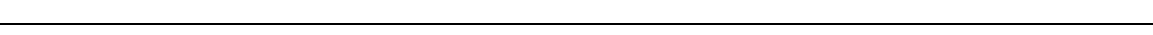
TSA. Protein level of SRSF5 was measured by immunoblotting and MG132 treatment was used as a positive control. b Endogenous SRSF5 is acetylated. Endogenous SRSF5 protein was puri fi ed from HEK293T cells after NAM and TSA treatment as indicated. Acetylation levels were analyzed by immunoblotting. c In vivo competition between ubiquitylation and acetylation of SRSF5 were revealed by Ni 2 + pull-down assay. d Overexpression of Tip60, but not other typical members of acetyltransferases, increases endogenous SRSF5 acetylation at K125. e Tip60 knockdown sharply reduced SRSF5 acetylation level. f Acetyltransferase-activity of Tip60 is required for SRSF5 K125 acetylation. Flag-tagged SRSF5 was co-transfected with HA-tagged Tip60 WT or catalytically inactive mutant G380E into HEK293T cells. Acetylation was determined by immunoblotting. g Puri fi ed GST – SRSF5 fusion proteins